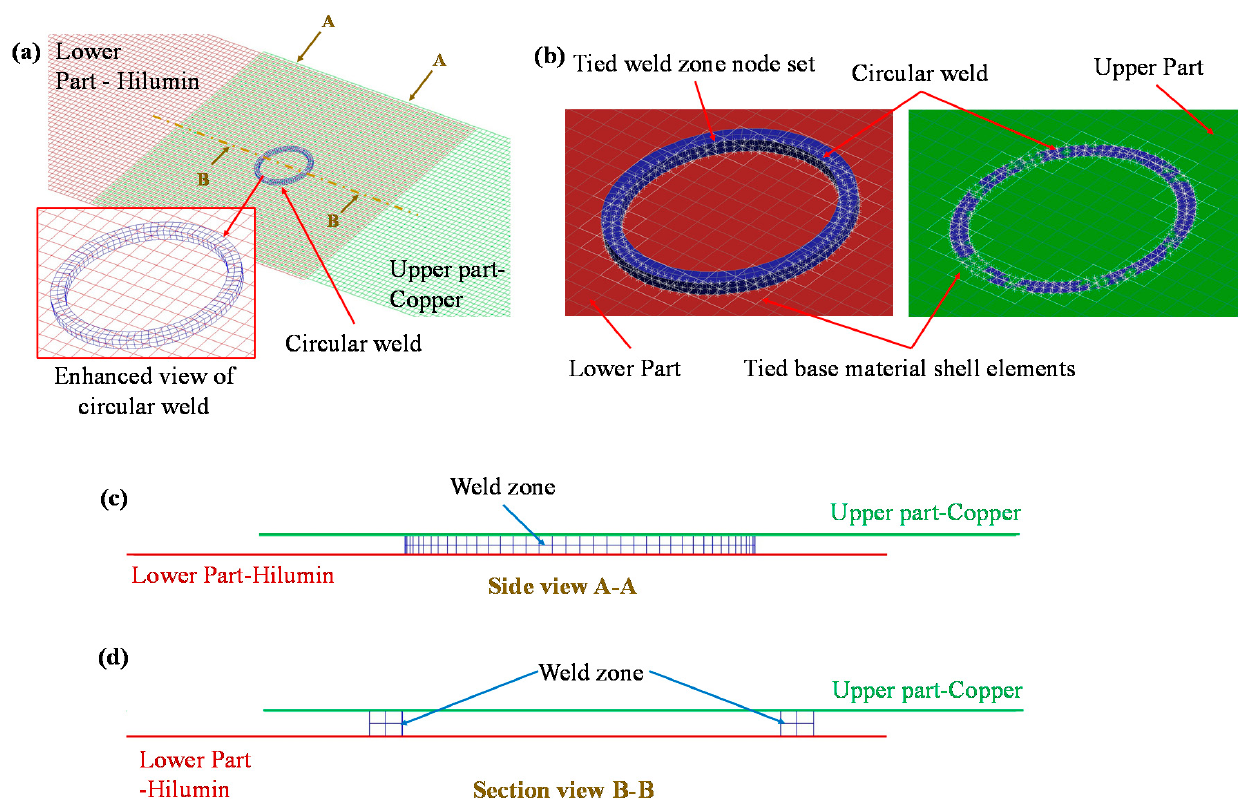
Figure 5. Details of the mesh model: ( a ) a closer look at the joint, ( b ) illustration of contact modelling, ( c ) side view of the weld A-A, and ( d ) section view at the centre of the weld B-B.